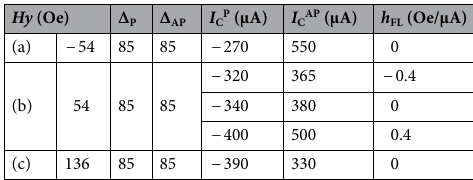
Table 2. Parameters used to fit the experimental data on pulse current induced switching. The other fixed parameters are: H K : 300 Oe, H s : 54 Oe.